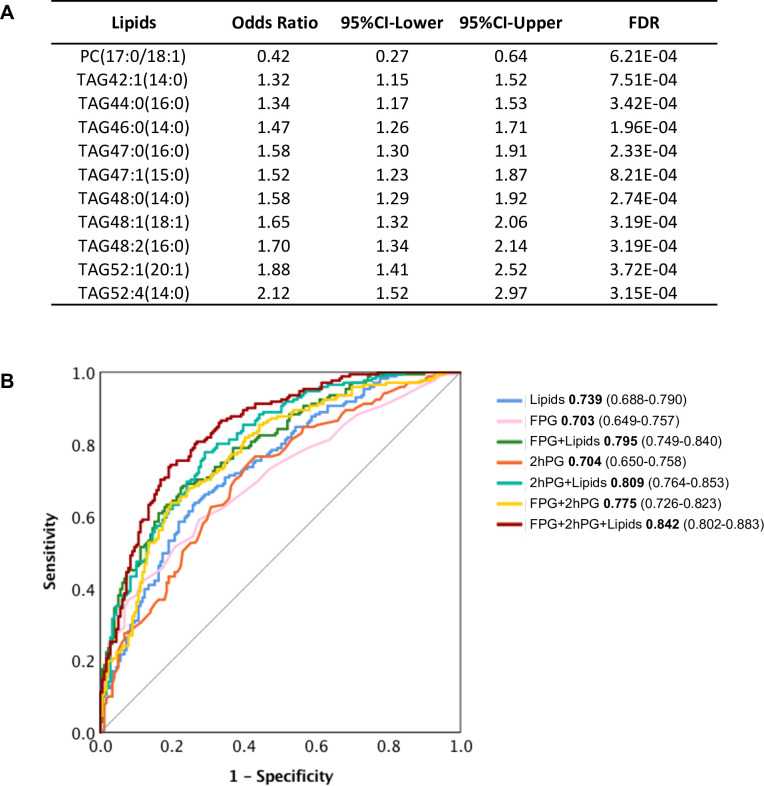
Selected lipid signature predicting future T2D.(A) Top 11 lipids with the best predictive performance were selected for building a model to predict future T2D. Their odds ratio and 95% CI of T2D association were shown. (B) Predictive performance of logistic regression model was demonstrated as ROC curve. The area under the curve and 95% CI in each model were shown.Figure 6—source data 1.Predictive performance of logistic regression model.